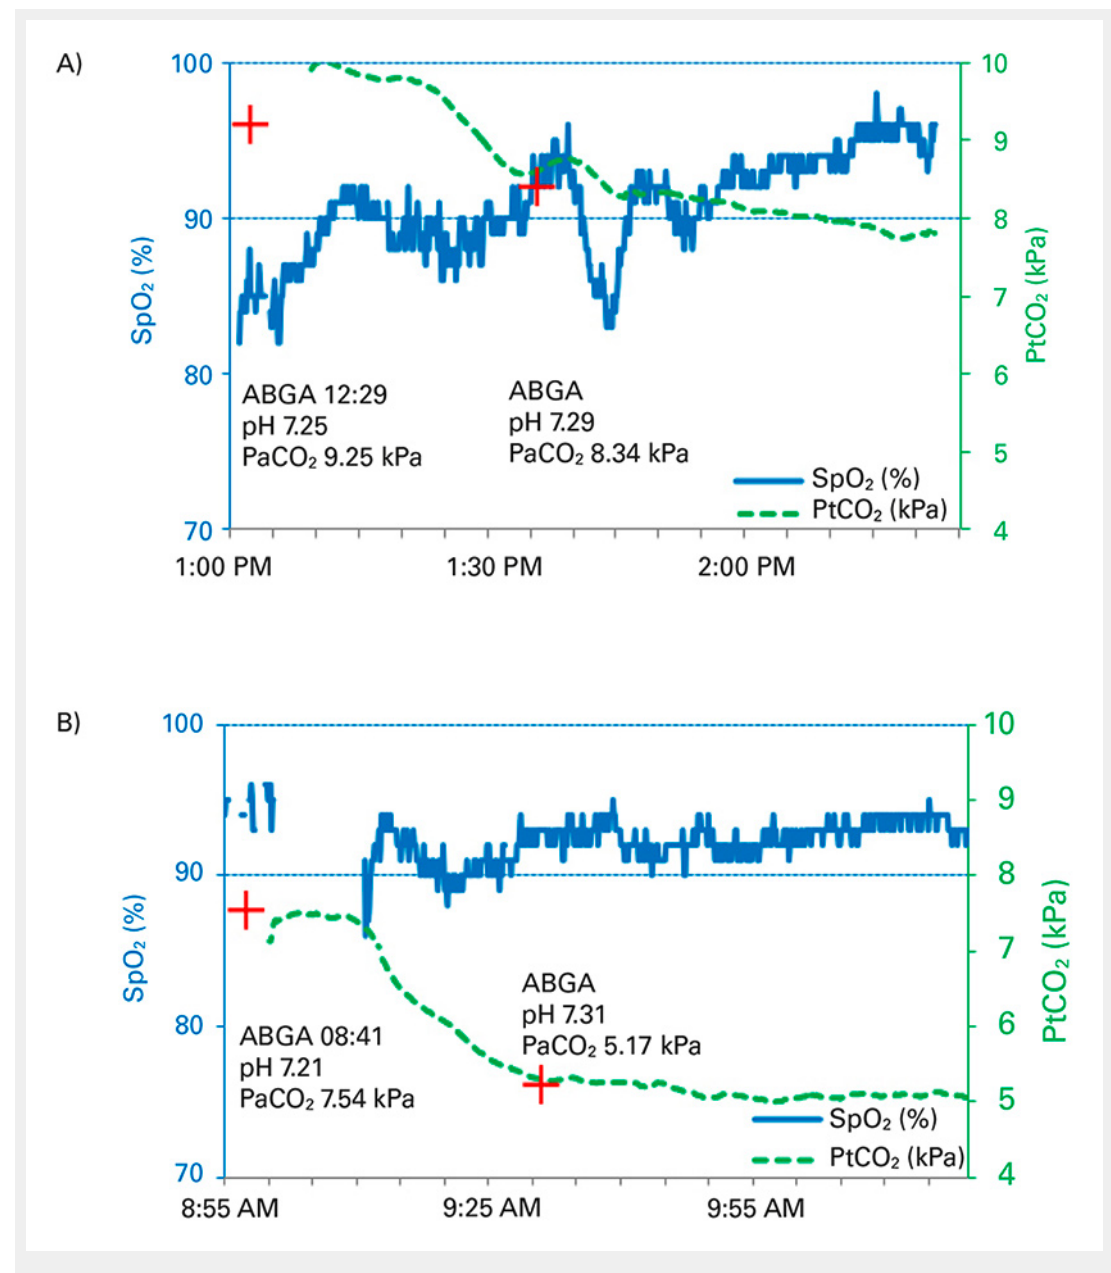
Figure 2 Real-time PtCO 2 monitoring of two patients undergoing noninvasive ventilation. (A) Exacerbated chronic obstructive pulmonary disease, (B) Acute cardiac pulmonary oedema. The red cross indicates the PaCO 2 values from the arterial blood gas analysis, PtCO 2 values (dashed lines) and SpO 2 values (solid lines) are demonstrated. ABGA = arterial blood gas analysis; PaCO 2 = arterial partial pressure of CO 2 ; SpO 2 = oxygen